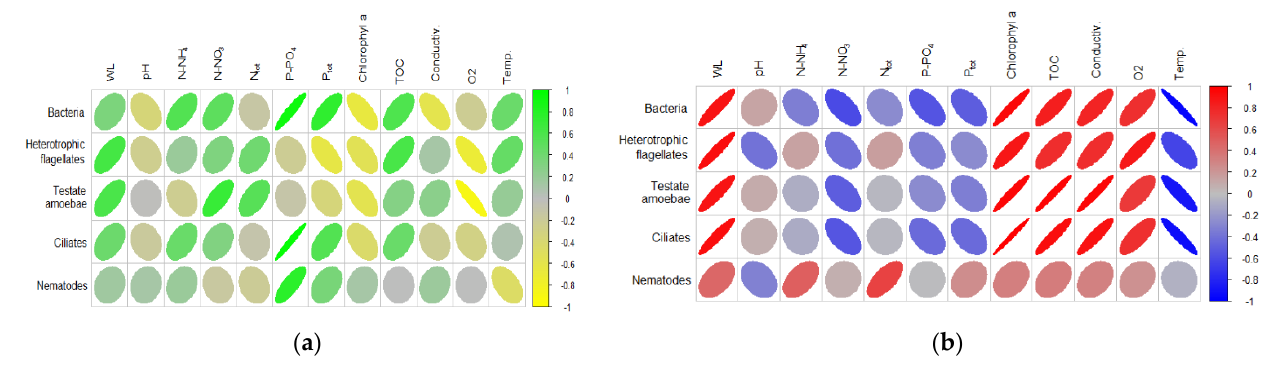
Figure 7. Correlogram between all related physical and chemical parameters and microbial and nematode communities before and ( a , b ) after fire. The ellipse angulation and the colour intensity are proportional to the Pearson correlation coefficient: Positive correlations are drawn in green/red whereas the negative correlations are in yellow/blue.